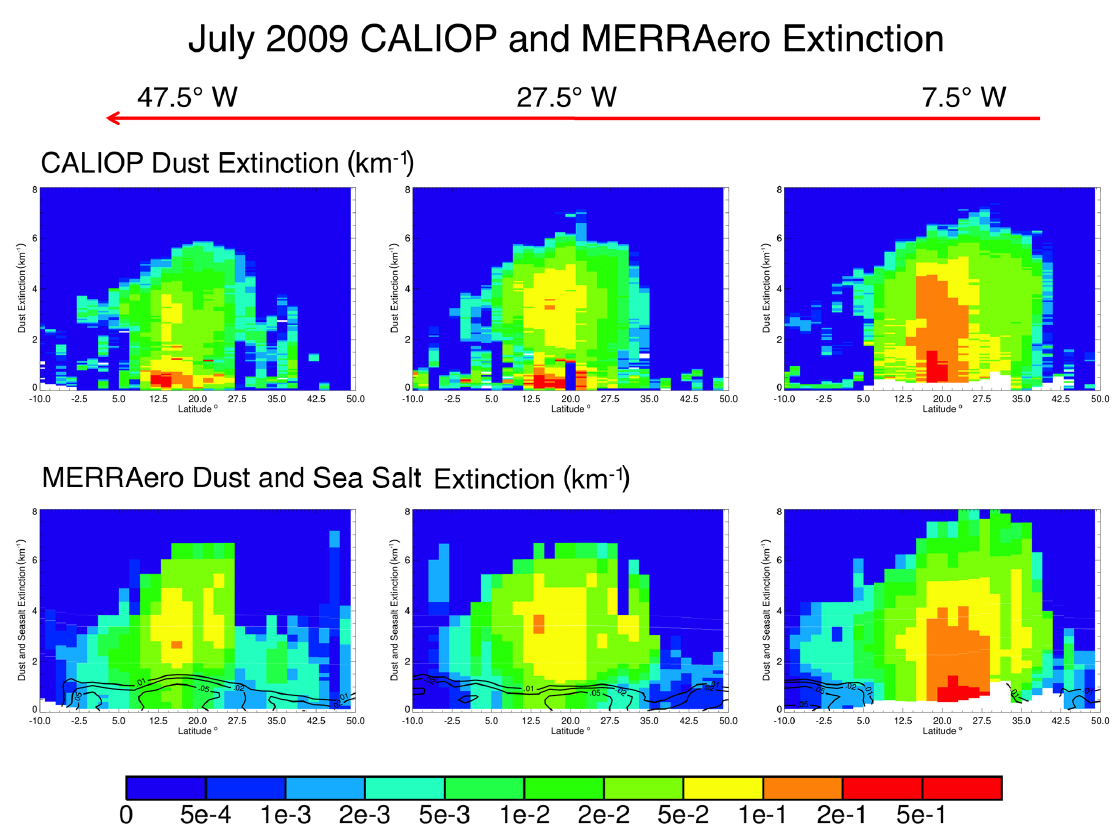
Figure 4. July 2009 CALIOP (top) dust and MERRAero (bottom) dust and sea salt (contour) Level 3 extinction at several north–south slices at longitudes 47.5, 27.5, and 7.5 ◦